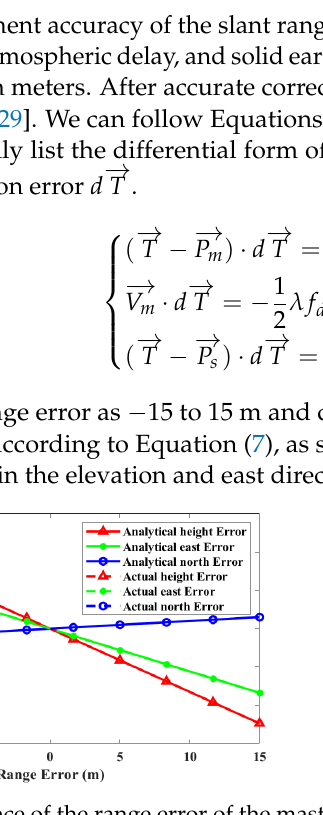
Figure 3. The influence of the range error of the master satellite on the three-dimensional geoloca- tion